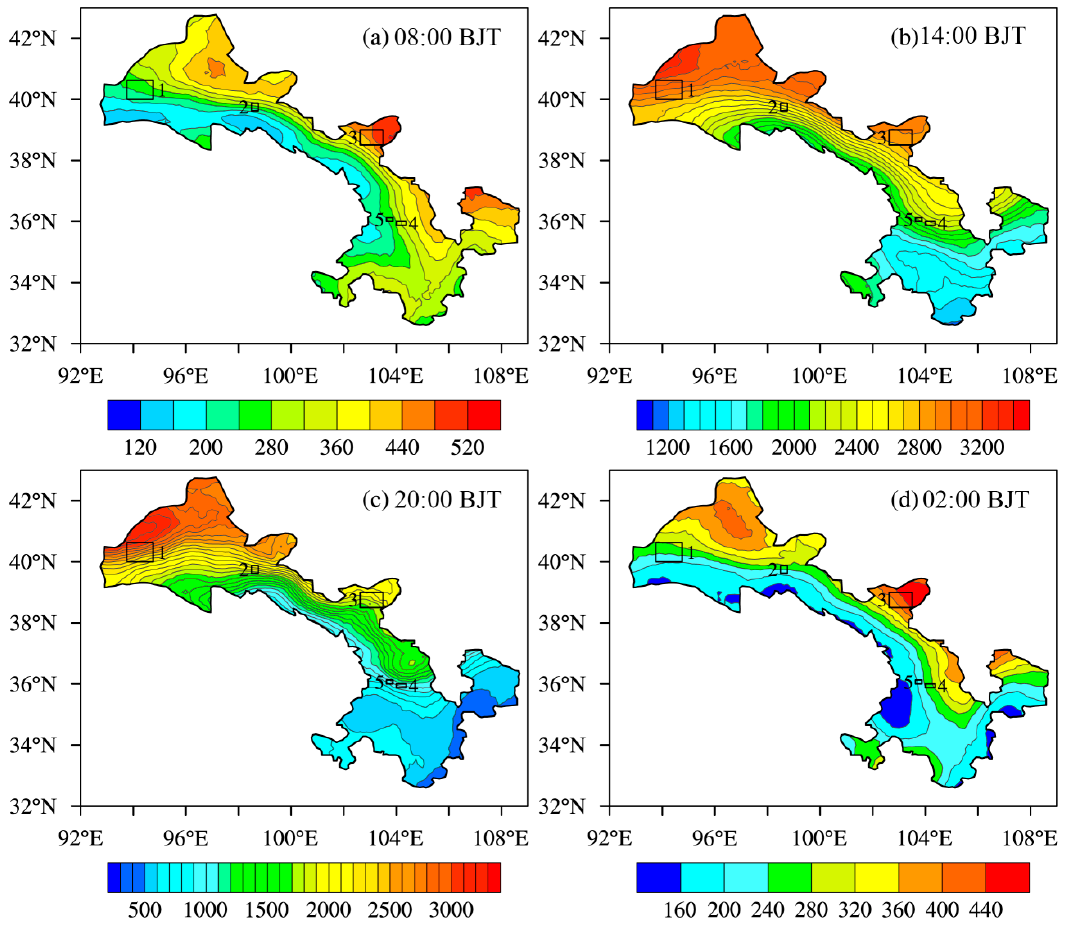
Figure 5. The spatial distribution of the atmospheric boundary layer height at four times in the summer of 2016 over Gansu province in northwest China. ( a ) 08:00 BJT, ( b ) 14:00 BJT, ( c ) 20:00 BJT, and ( d ) 02:00 BJT. The five rectangles labeled 1–5 stand for the area position of Dunhuang, Jiuquan, Minqin, Yuzhong and Lanzhou, respectively.